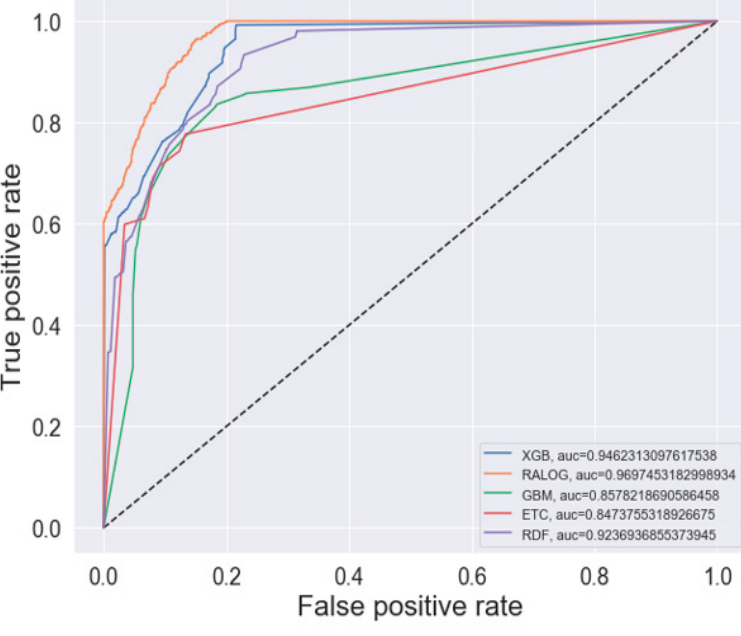
Figure 8. ROC curve after RFE.